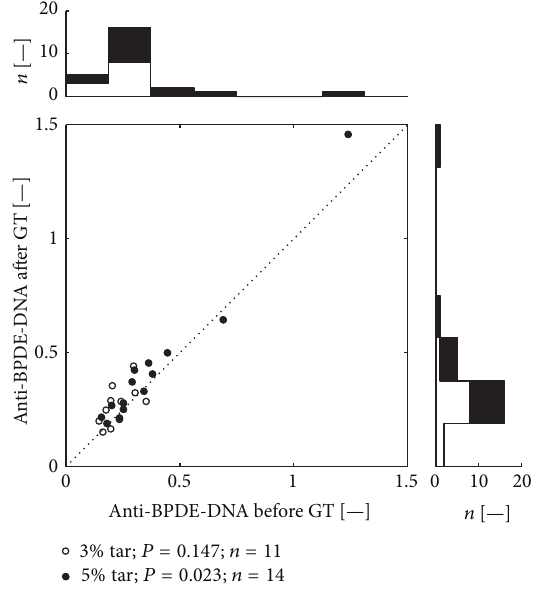
Figure 3: Distribution of values of anti-BPDE-DNA (smokers). Legend: Scatter plot depicts anti-BPDE-DNA values before and after the GT therapy. All together 25 dots represent 50 measurements, each dot belongs to a one